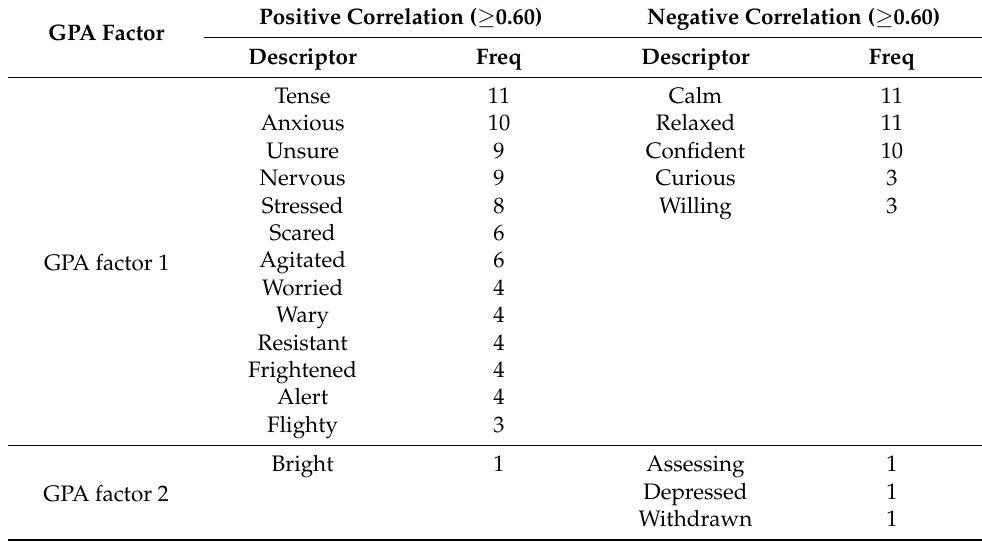
Table 1. The descriptors most used by the assessors (frequencies over the 13 observers) with the highest positive and negative correlation to factors 1 and 2 of the consensus